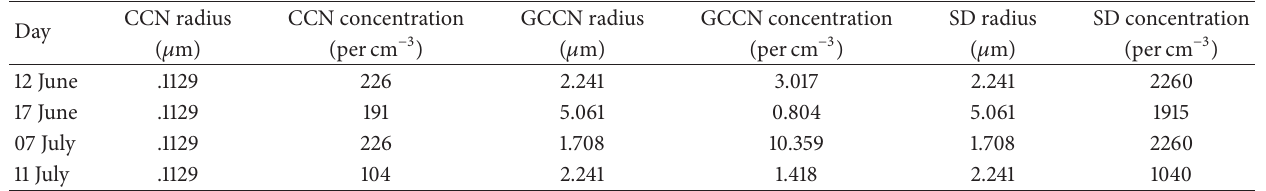
Table 2: CCN, GCCN, and SD